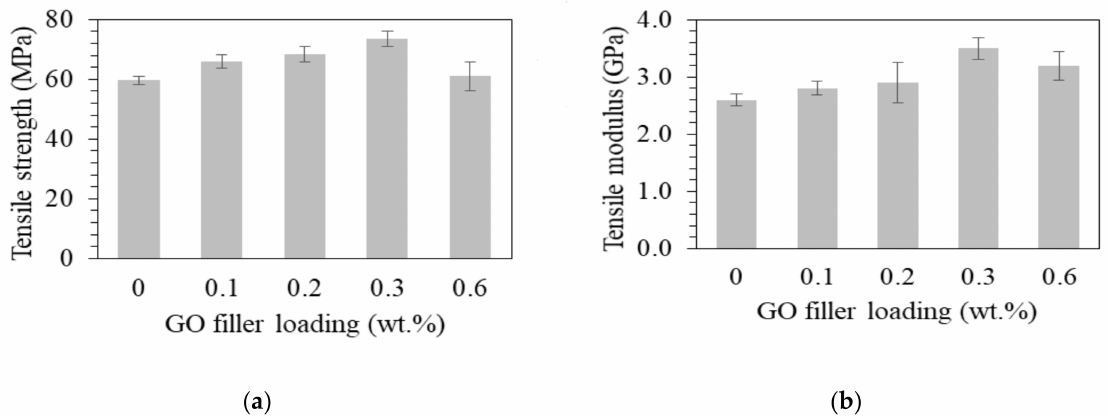
Figure 8. ( a ) Tensile strength and ( b ) tensile modulus results for pure bio-epoxy and bio-epoxy/GO composites containing 0.1–0.6 wt.% GO.